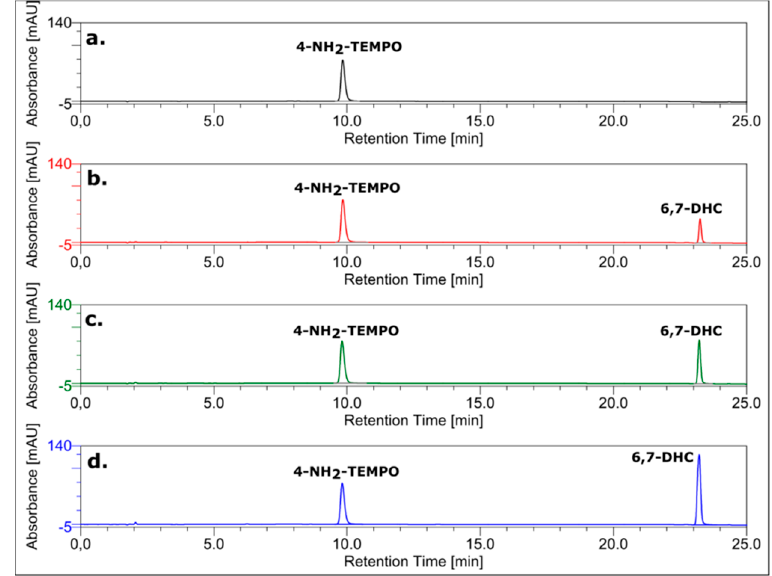
Figure 7. RP-HPLC chromatograms of: ( a ) 0.2 mM 4-amino-TEMPO; ( b ) the mixture of 0.2 mM 4-amino-TEMPO and 0.2 mM 6,7-dihydroxycoumarin; ( c ) the mixture of 0.2 mM 4-amino-TEMPO and 0.4 mM 6,7-dihydroxycoumarin; ( d ) the mixture of 0.2 mM 4-amino-TEMPO and 0.8 mM 6,7-dihydroxycoumarin. The chromatograms were recorded at 260 nm.